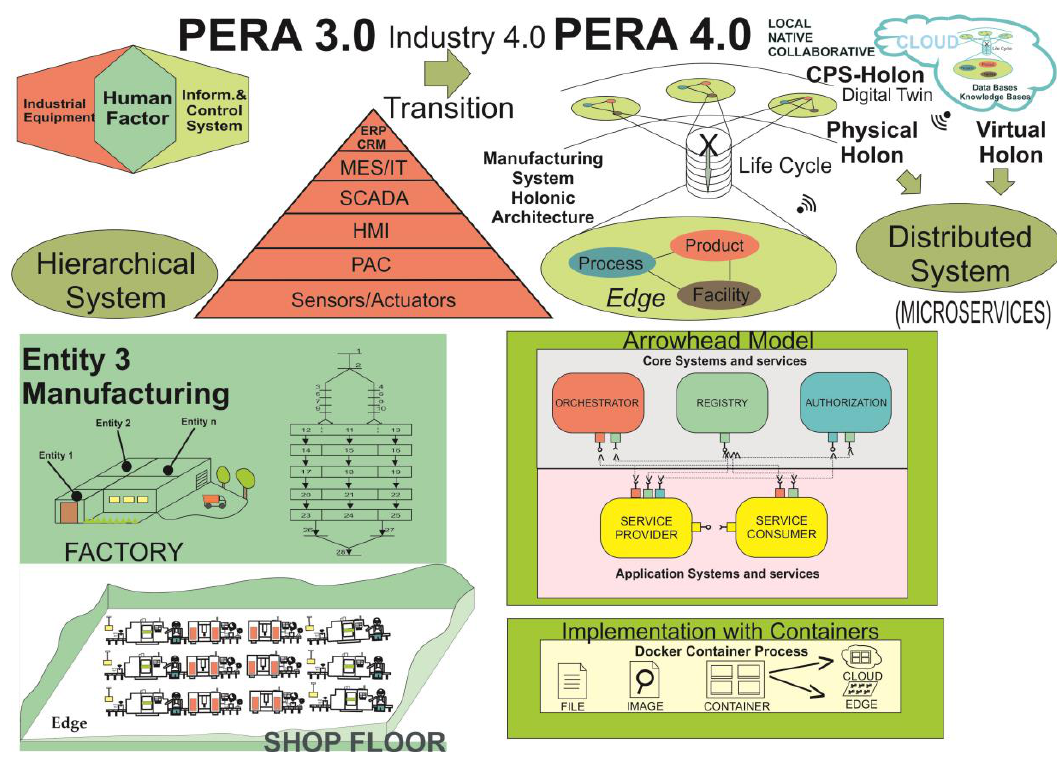
Figure 12. Evolution of the PERA control architecture to the PERA 4.0 architecture.